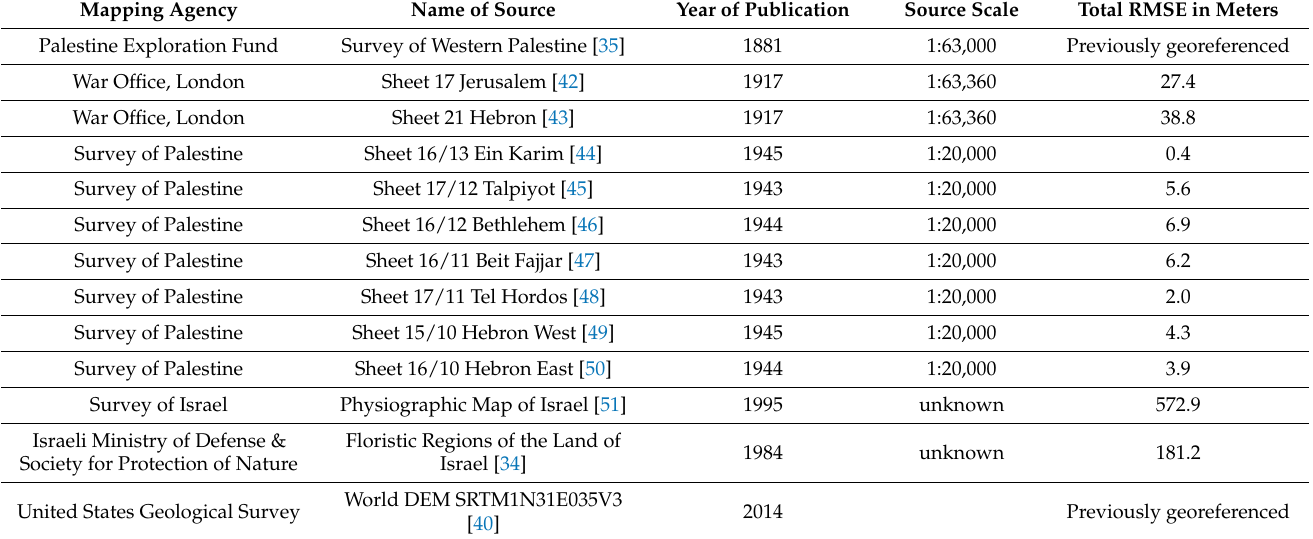
Table 1. The cartographical sources used in the research. For each cartographical source, the following details were provided: the agency that created the map, the name of the source, the year the source was published, the scale of the source and, if the source was georeferenced in this research, and the total Root Mean Square Error (RMSE). Mapping